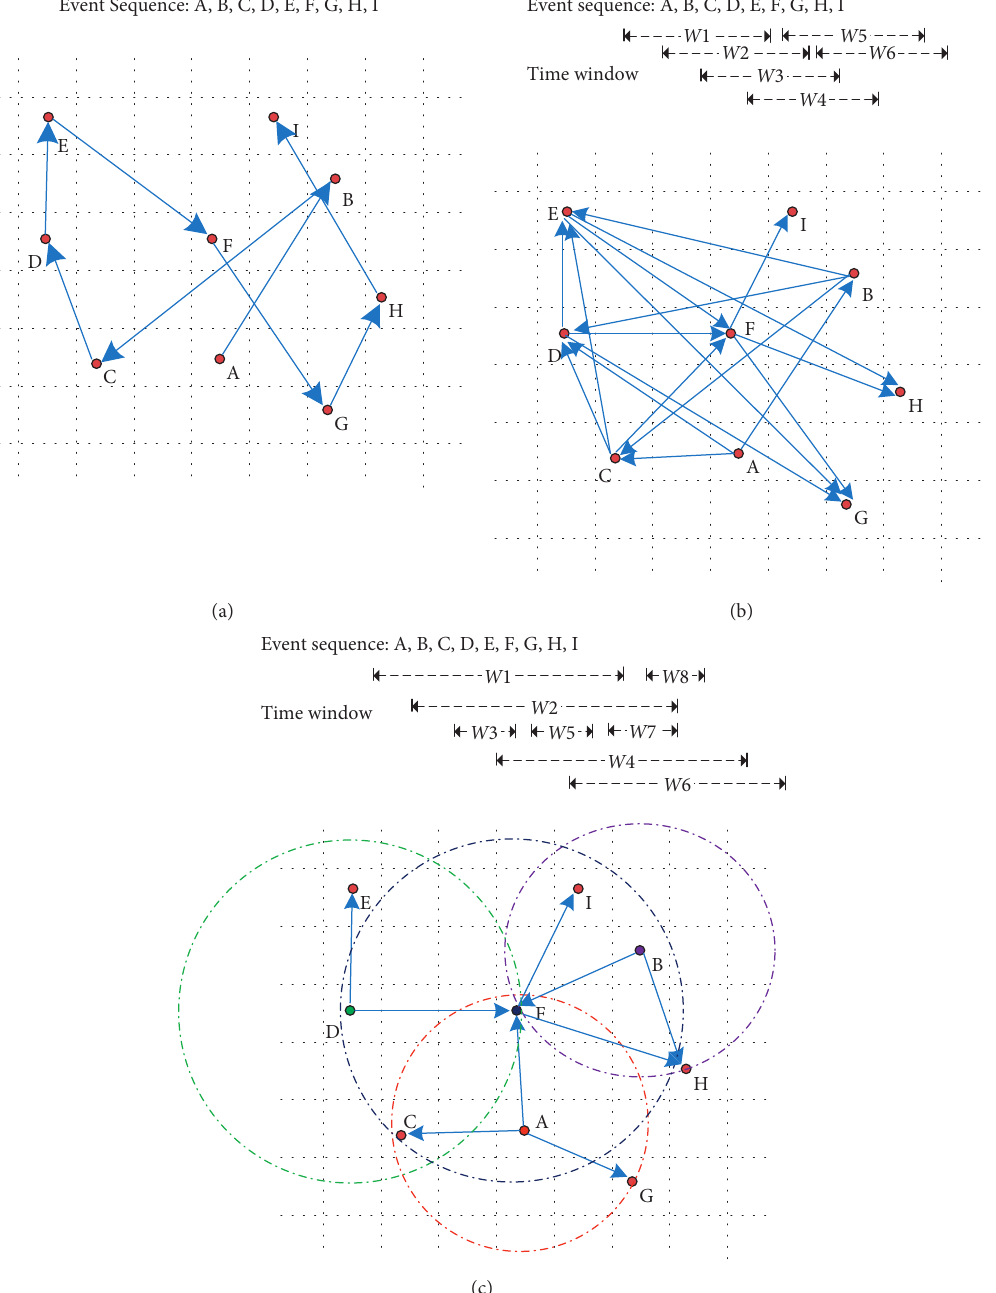
Figure 1: The schematic diagram of network construction methods. The time windows are represented by w Event sequence represents the sequence of the events occurring in the example. (a) Time series, (b) time window, and (c) space-time influence domain. The dashed colored circles in (c) represent the node’s space influence domain with the same